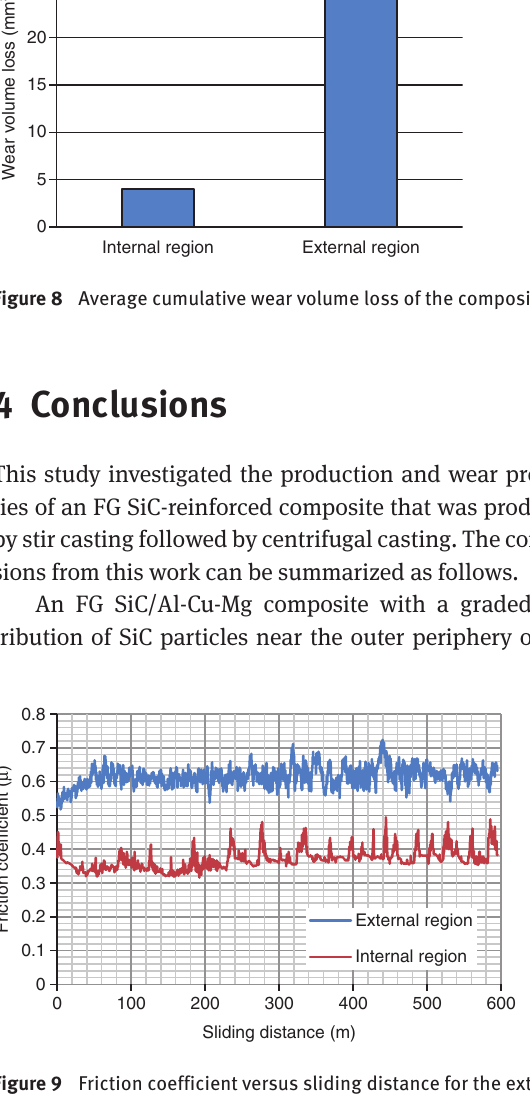
Figure 9 Friction coefficient versus sliding distance for the external and internal regions of the composite.